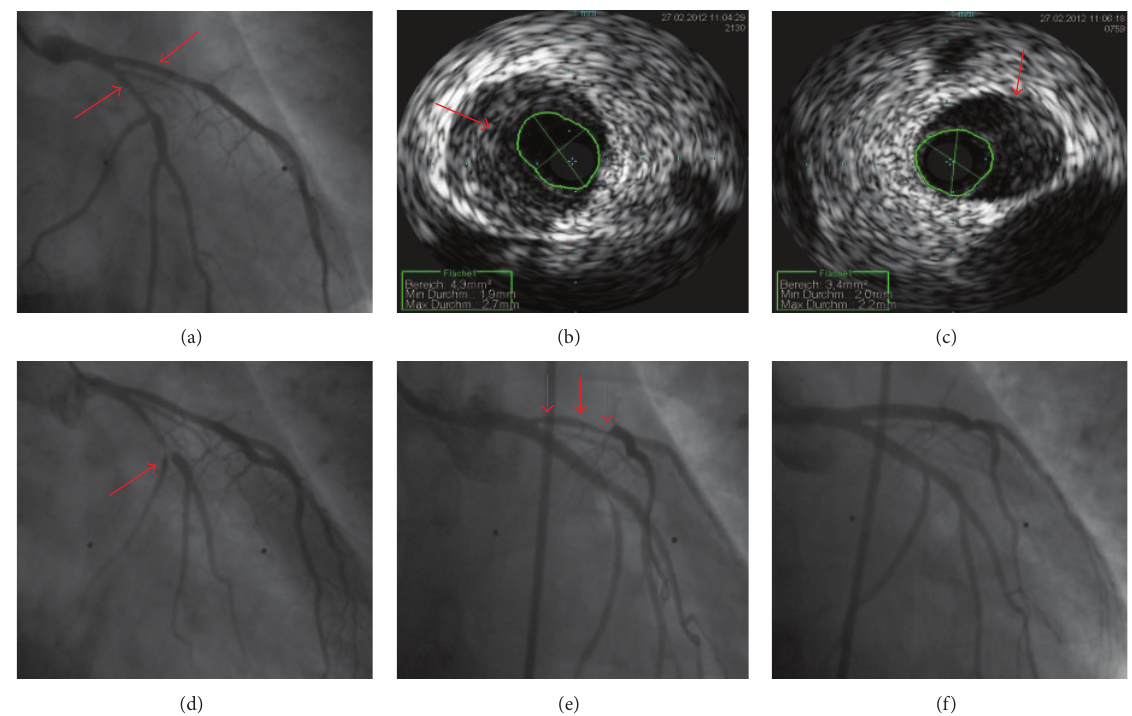
Figure 2: (a) clearly shows luminal narrowing in both proximal LAD and LCX in the control angiogram done 3 days later. (b) and (c) show IVUS confirmation of the diagnosis and estimation of minimum luminal area (4.3 mm 2 in LAD and 3.4 mm 2 in LCX). (d) shows proximal LCX tight lesion just after IVUS removal. (e) shows further luminal narrowing of the LAD due to milking of the hematoma after LCX-LM stenting. The final angiogram (f) shows the end result after LM-LAD and LM-LCX stenting (culotte